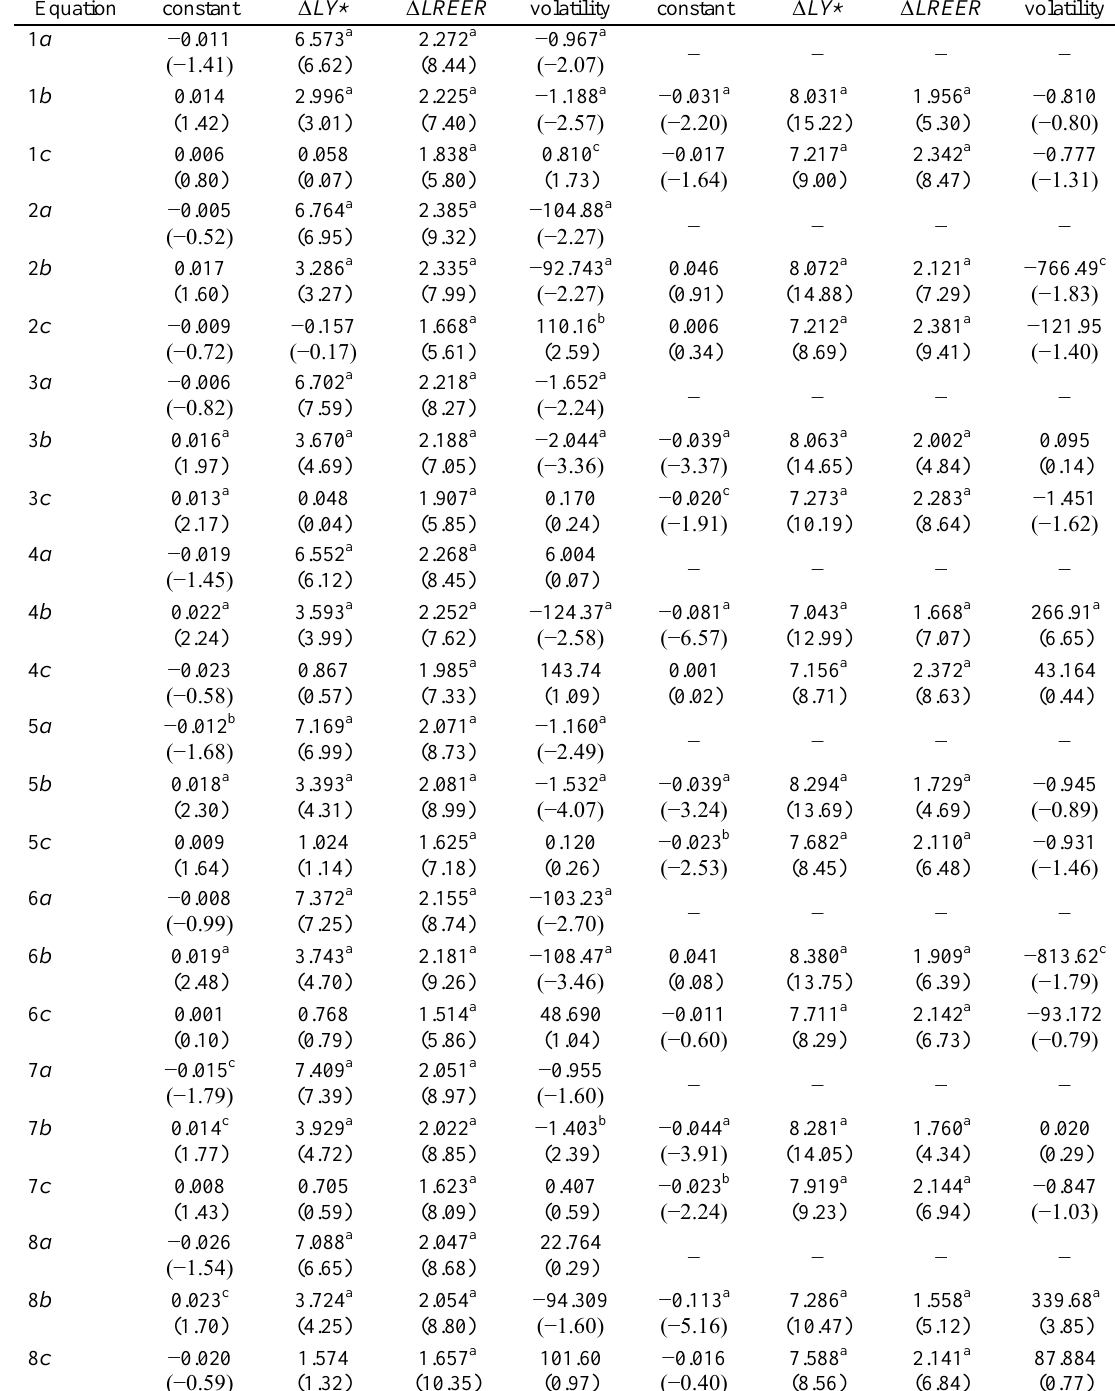
Table 7 : Exports and exchange rate volatility: